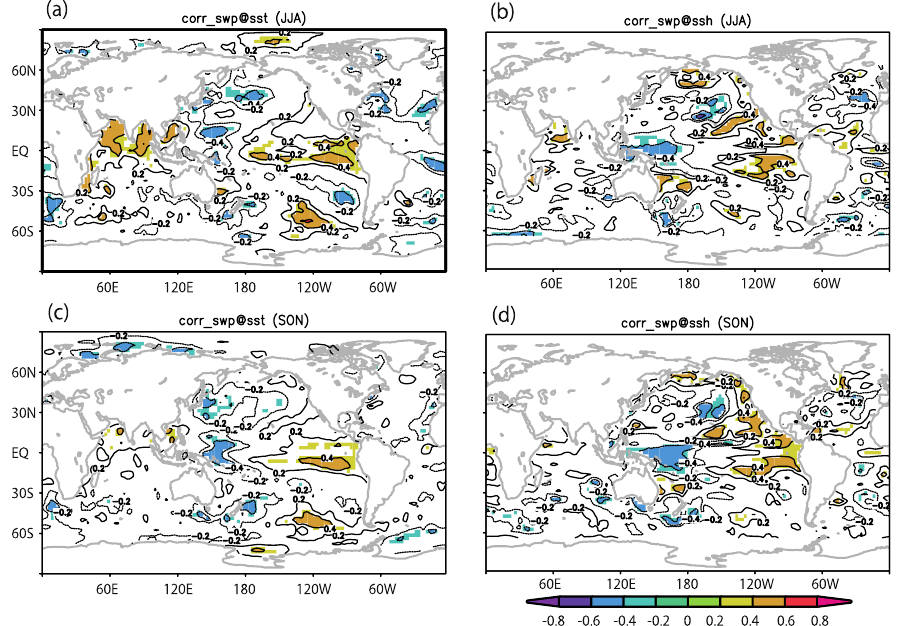
Figure 11. Same as Figure 9 but for the DJF observed TCF anomaly (defined as occurrence in 5° × 5° bins, units are TCs per season) over the SWP region (averaged over 10 – 30° S, 150 – 180° E). ( a ) JJA SST, ( b ) JJA SSH, ( c ) SON SST, ( d ) SON SSH.